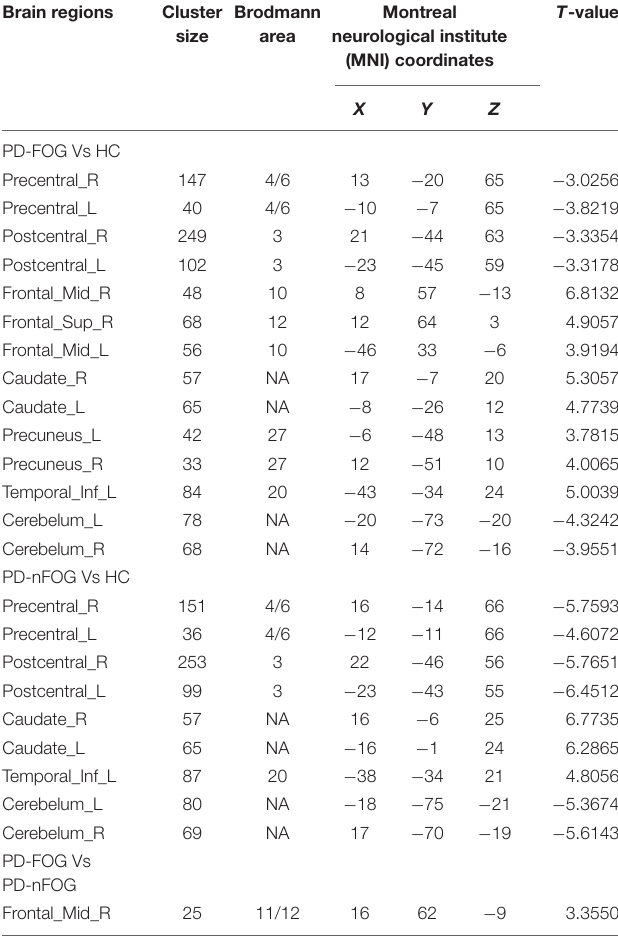
TABLE 2 | Differences in the degree centrality (DC) values between PD patients and HCs. Brain regions Cluster